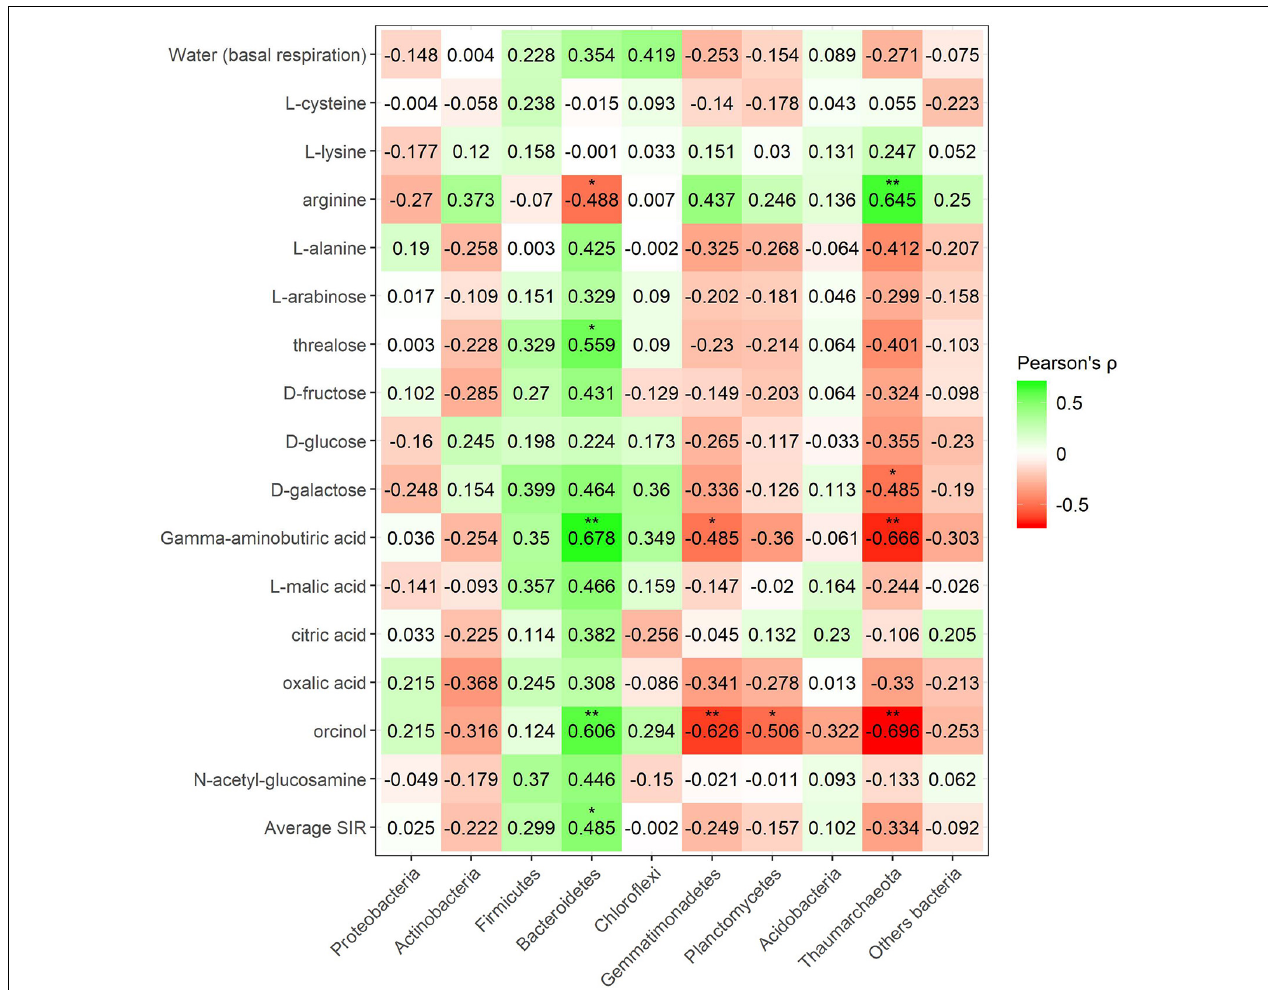
FIGURE 7 | Heatmap of Pearson’s correlation coefficient ( r ) between the most abundant fungal phyla (plant–soil effect) and the SIR results of the different carbon sources. Heatmap colors represent the Pearson correlations ranges, from red (negative correlation), passing through white (no correlation) to green (positive correlation). Significant results are indicated by an